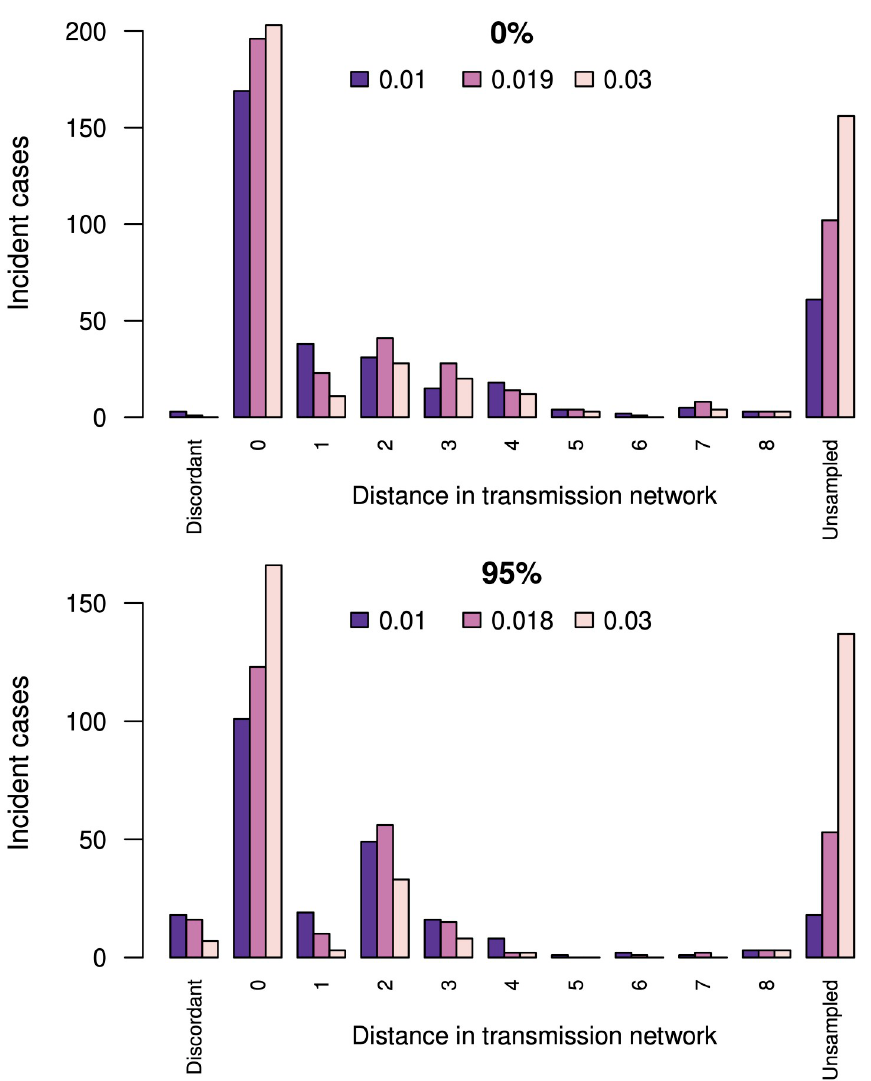
Fig 5. Concordance between predicted growth in phylogenetic clusters and the actual (simulated) transmission network. The top and bottom barplots summarize phylogenetic clusters obtained under bootstrap thresholds of 0% and 95%, respectively. Bars correspond to the number of incident cases mapped to phylogenetic clusters, coloured by three distance thresholds: d max = 0.01, the Δ AIC optimum, and d max = 0.03. Distance in transmission network is the shortest path in the transmission network between the incident case and any member of the predicted cluster. A distance of zero means the actual source individual is in the cluster, and distances greater than zero indicate the actual source was not sampled. Unsampled indicates that none of the sampled infections in the transmission history of an incident case were members of the phylogenetic cluster. Discordant indicates that the actual source individual was sampled but does not appear in the predicted